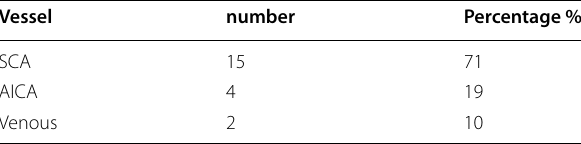
Table 3 Type of the offending vessel Vessel